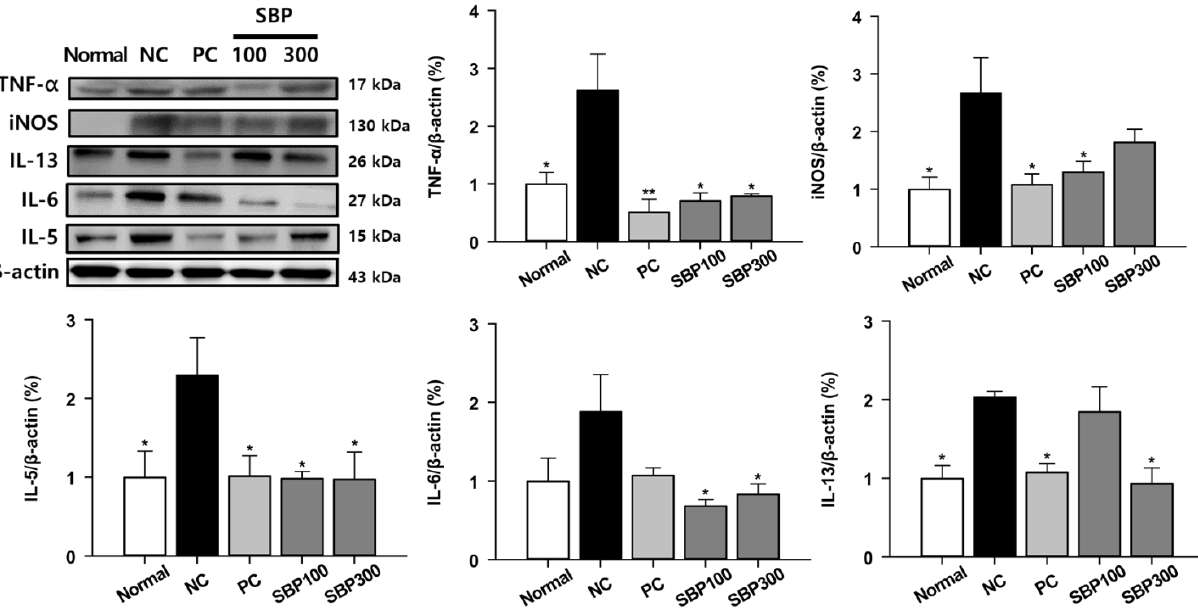
Figure 5. The expression of inflammatory cytokines in the lung tissue from OVA-treated mice. Normal, normal control; NC, negative control; PC, positive control; SBP100, SBP at 100 mg/kg; SBP300, SBP at 300 mg/kg. All values are expressed as mean ± SEM ( n = 7). p -value less than 0.05 was considered statistically significant. * p < 0.05 and ** p < 0.01 indicate statistical significance compared to the NC